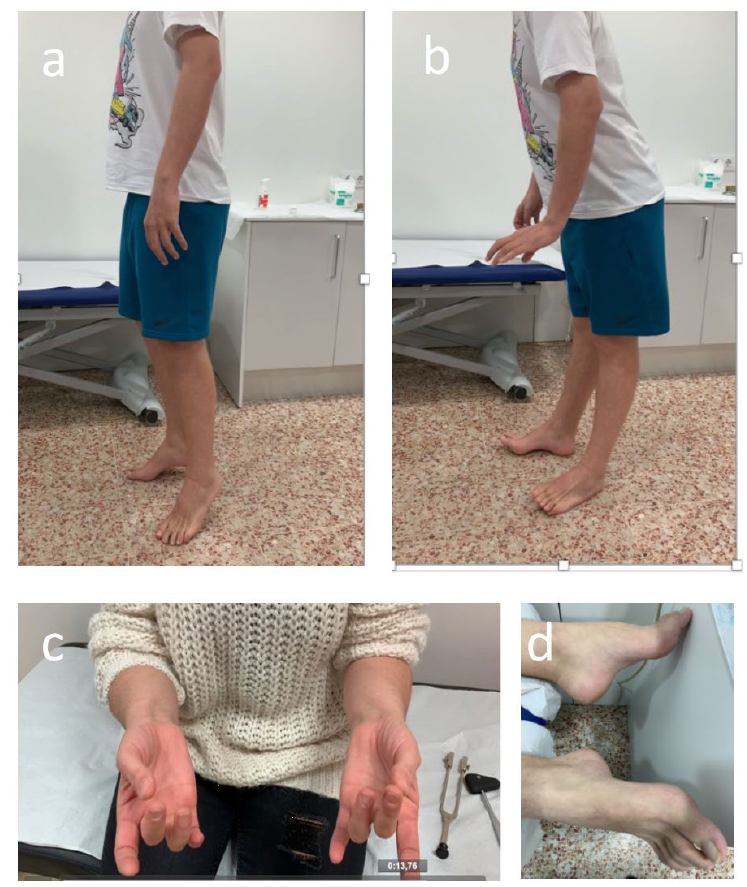
Figure 3. Abnormal ankle dorsiflexion strength test ( a , b ), clapping ( c ), and cavus feet ( d ) in patients with sensory-motor BVIN .